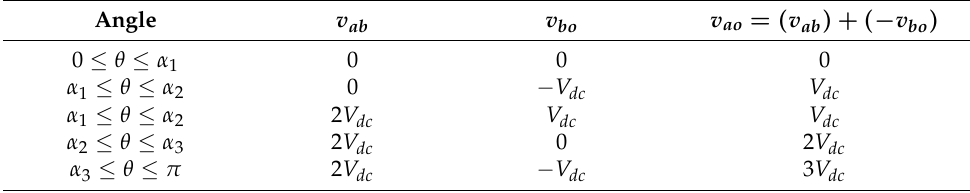
Table 4. Seven-level HMLI output